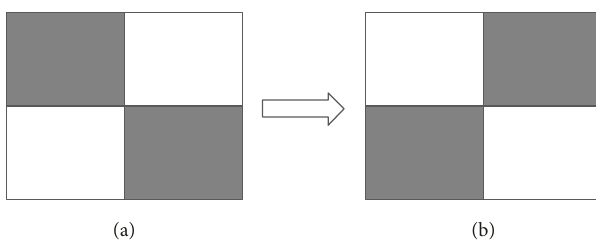
Figure 1: (a) Model two-phase medium. (b) The model of the medium, which is dual with respect to the initial original